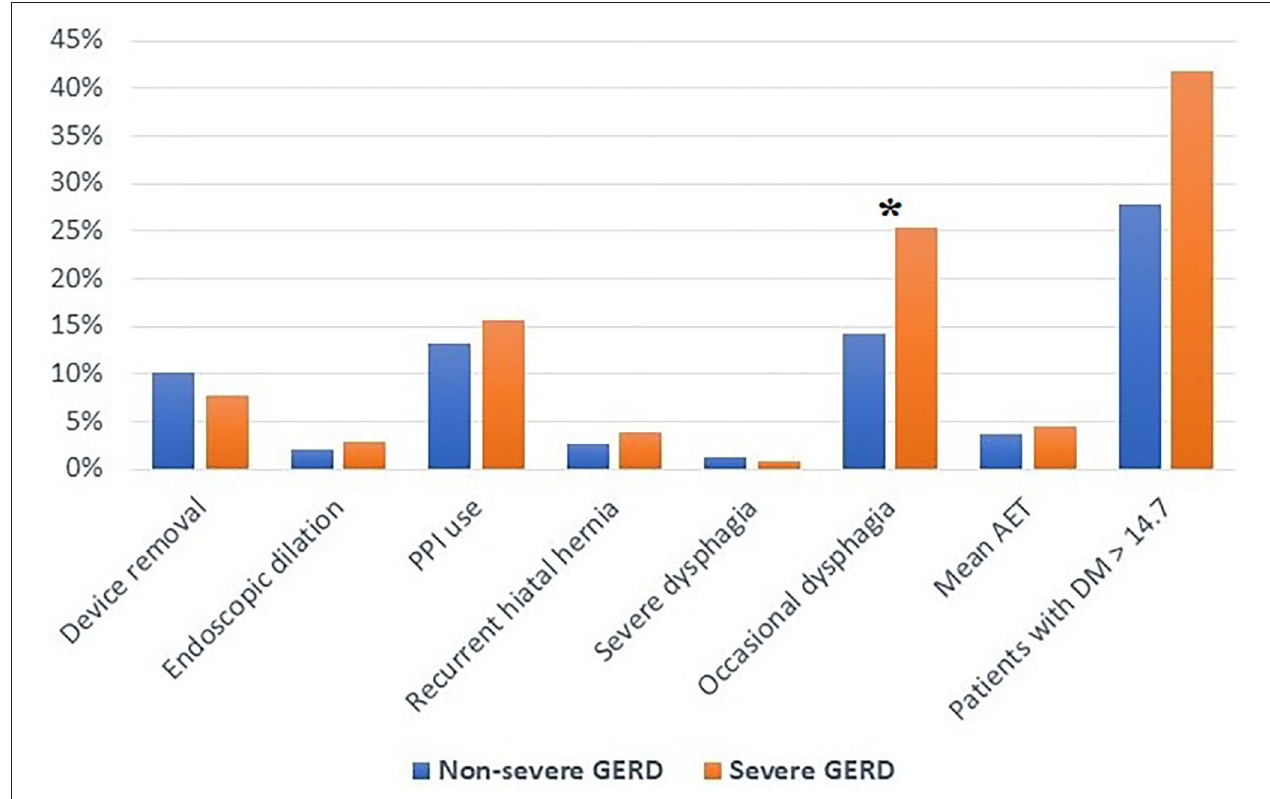
FIGURE 4 | Post-operative outcomes in patients with severe or non severe GERD. PPI, proton-pump inhibitors; AET, acid exposure time; DM, DeMeester score; GERD, gastro-esophageal reflux disease; * p < 0.05.